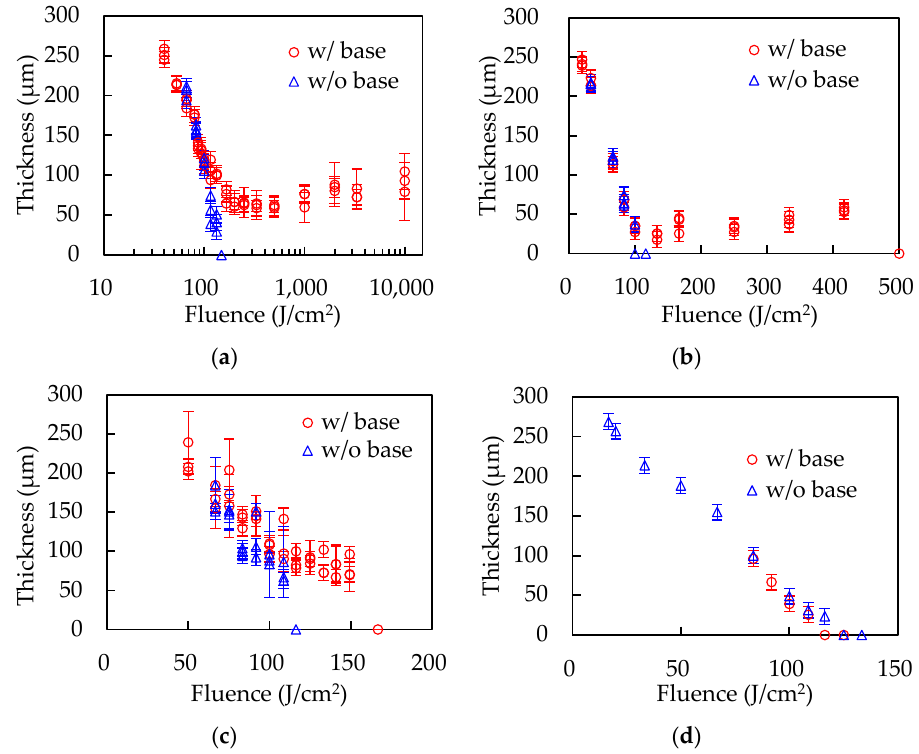
Figure 2. The thickness results of ( a ) PP, ( b ) PET, ( c ) PS, and ( d ) PTFE with or without the base.